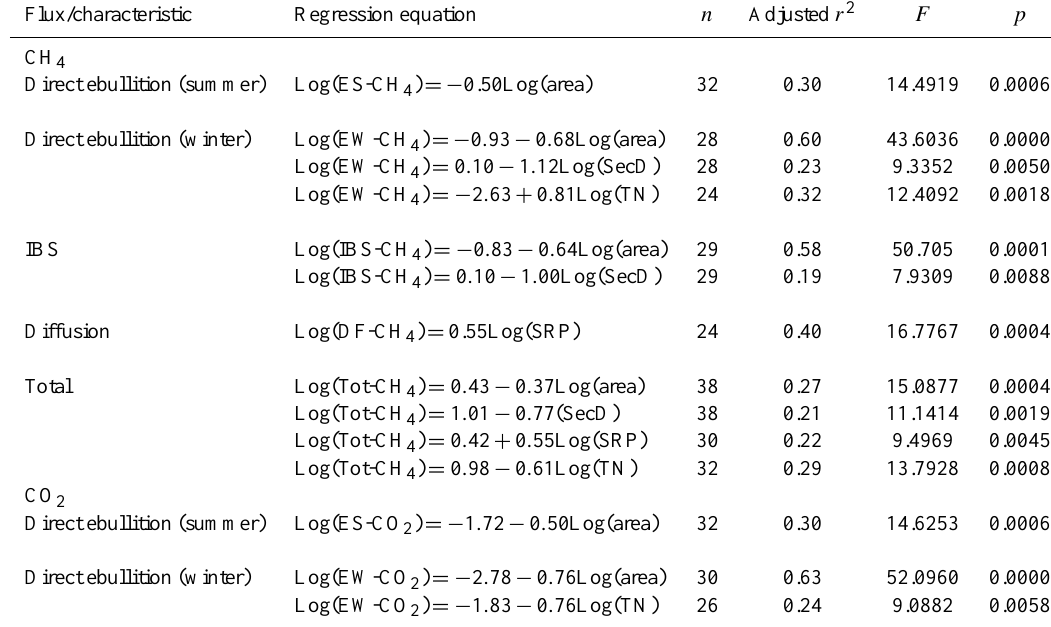
Table 4. Single regression equations for emission modes based on data from Table 1.